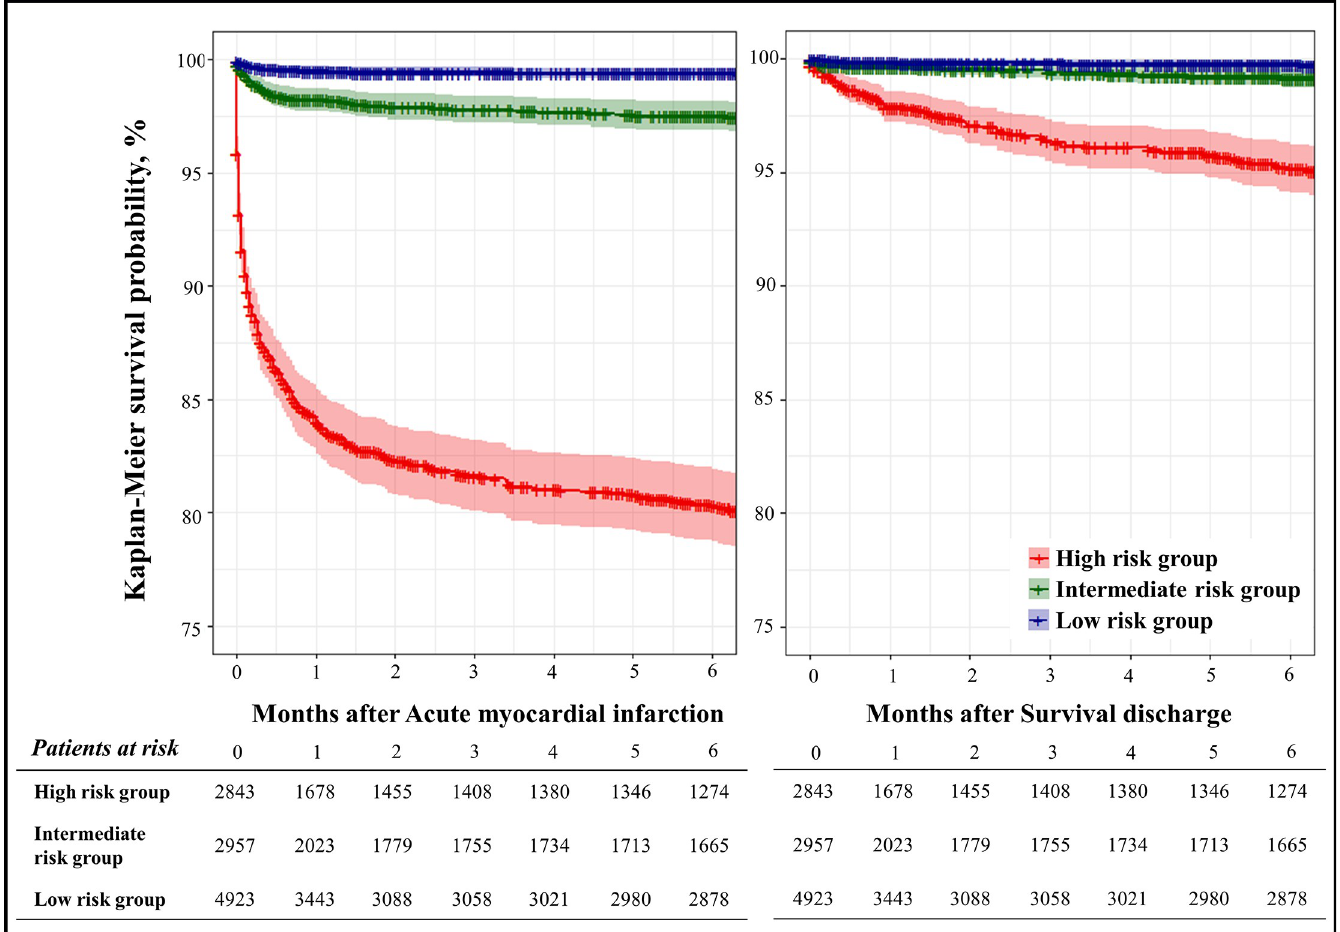
Fig 5. Kaplan-Meier survival curve stratified by deep-learning model risk score group.